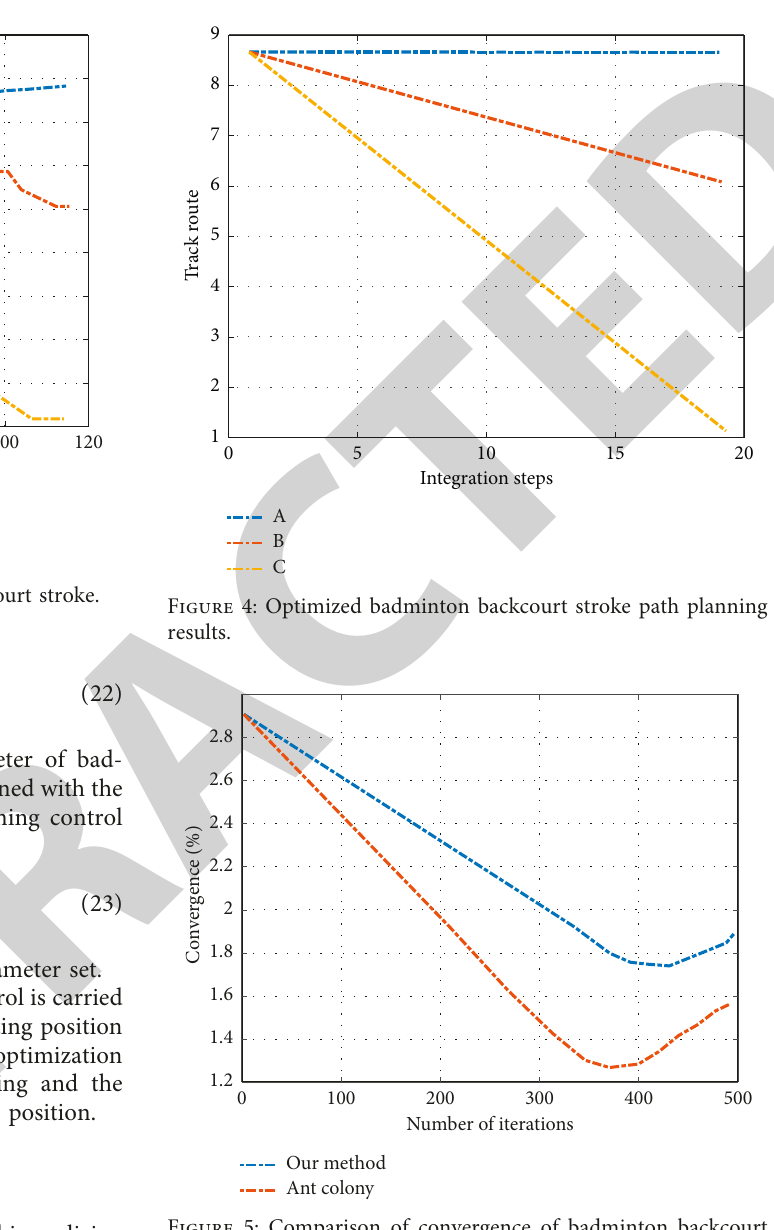
Figure 5: Comparison of convergence of badminton backcourt hitting route